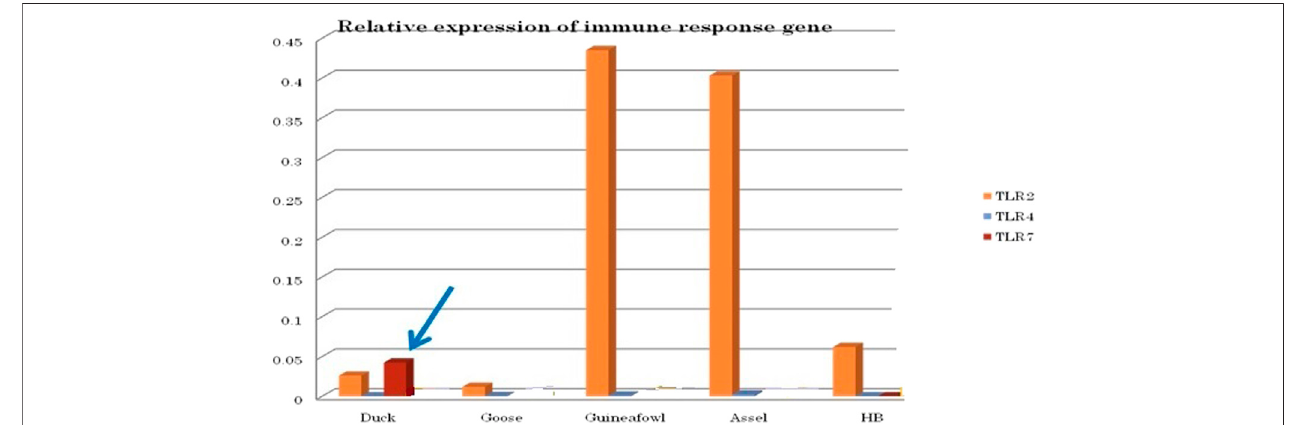
FIGURE 11 | Differential mRNA expression pro fi le of immune response genes of healthy duck with other poultry species.